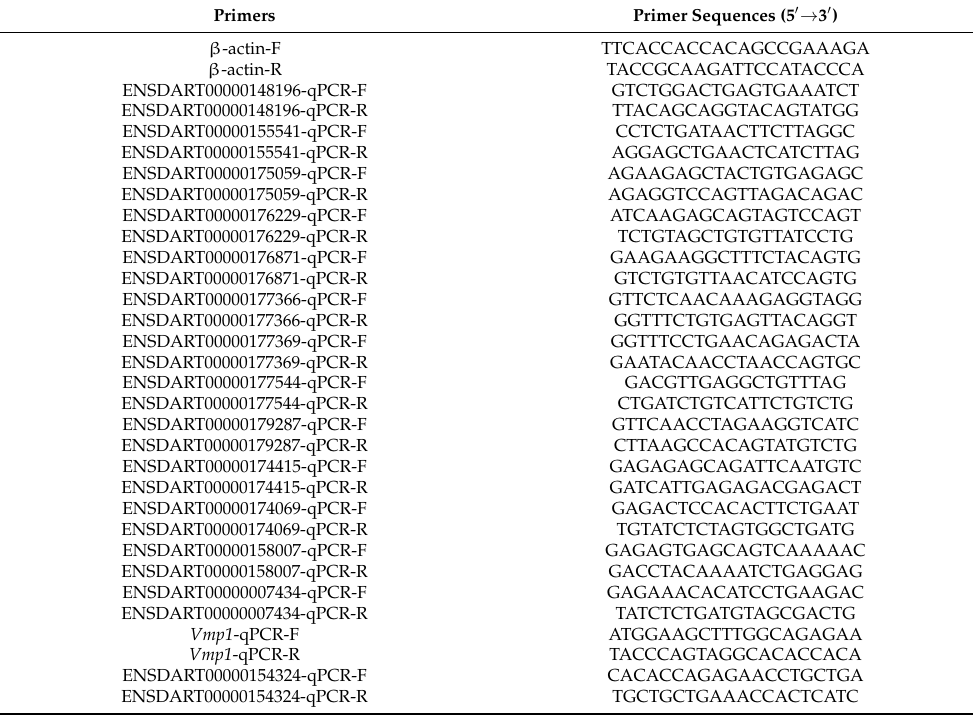
Table 2. The sequences of primers used in this